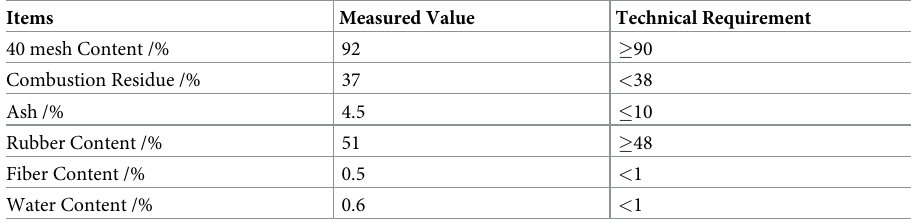
Table 3. The main technical performance of rubber powder used.